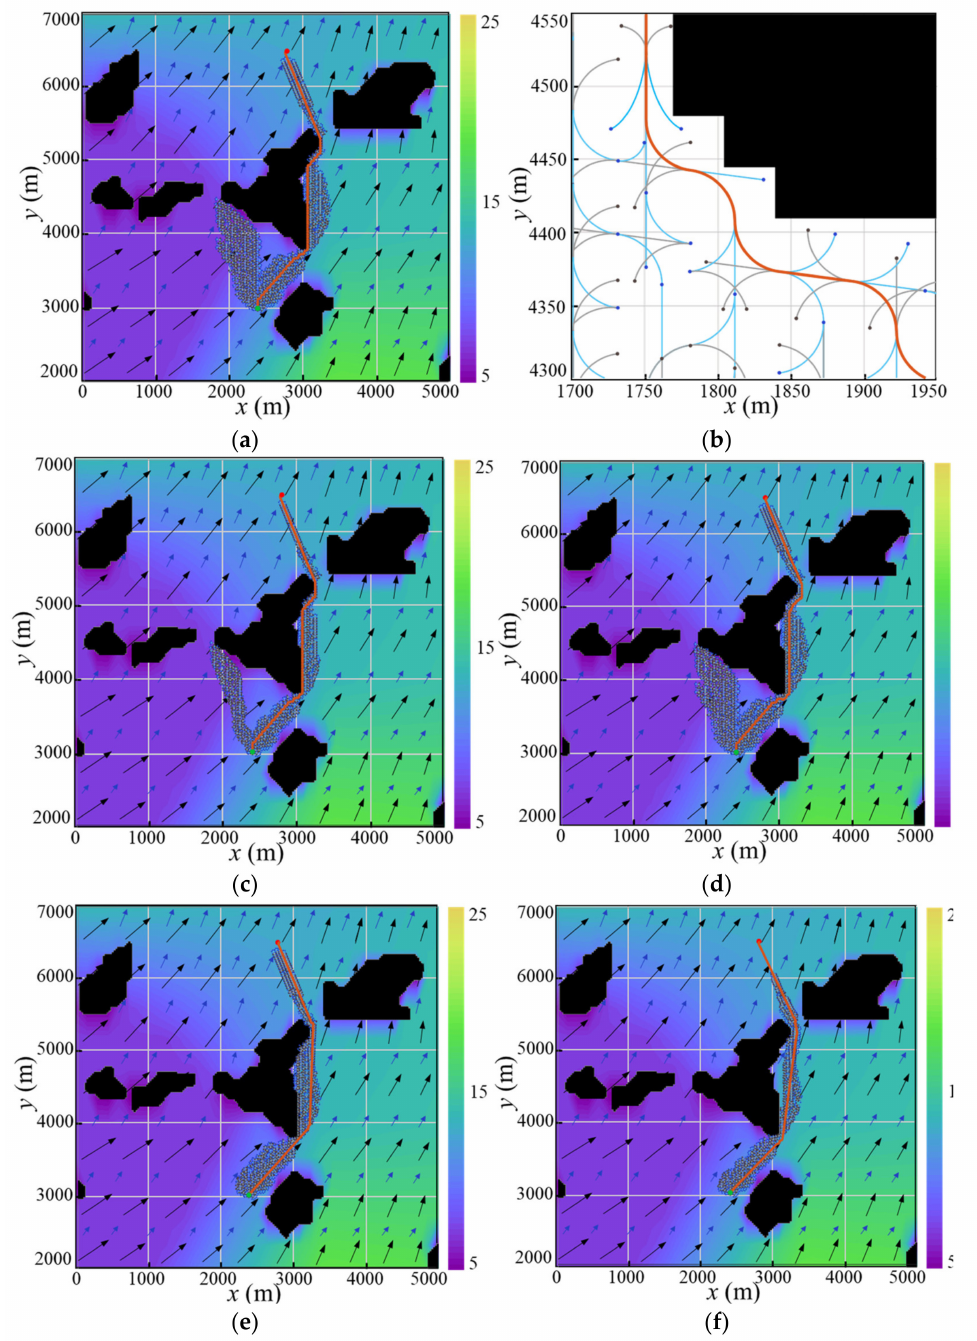
Figure 10. Comparison of motion planning paths. ( a ) Path of original HA* (Test 1); ( b ) A local enlargement of original HA*; ( c ) Path of efficiency-optimized HA* (Test 2); ( d ) Path of safety- optimized HA* (Test 3); ( e ) Path of energy-optimized HA* (Test 4); ( f ) Path of MOHA* (Test